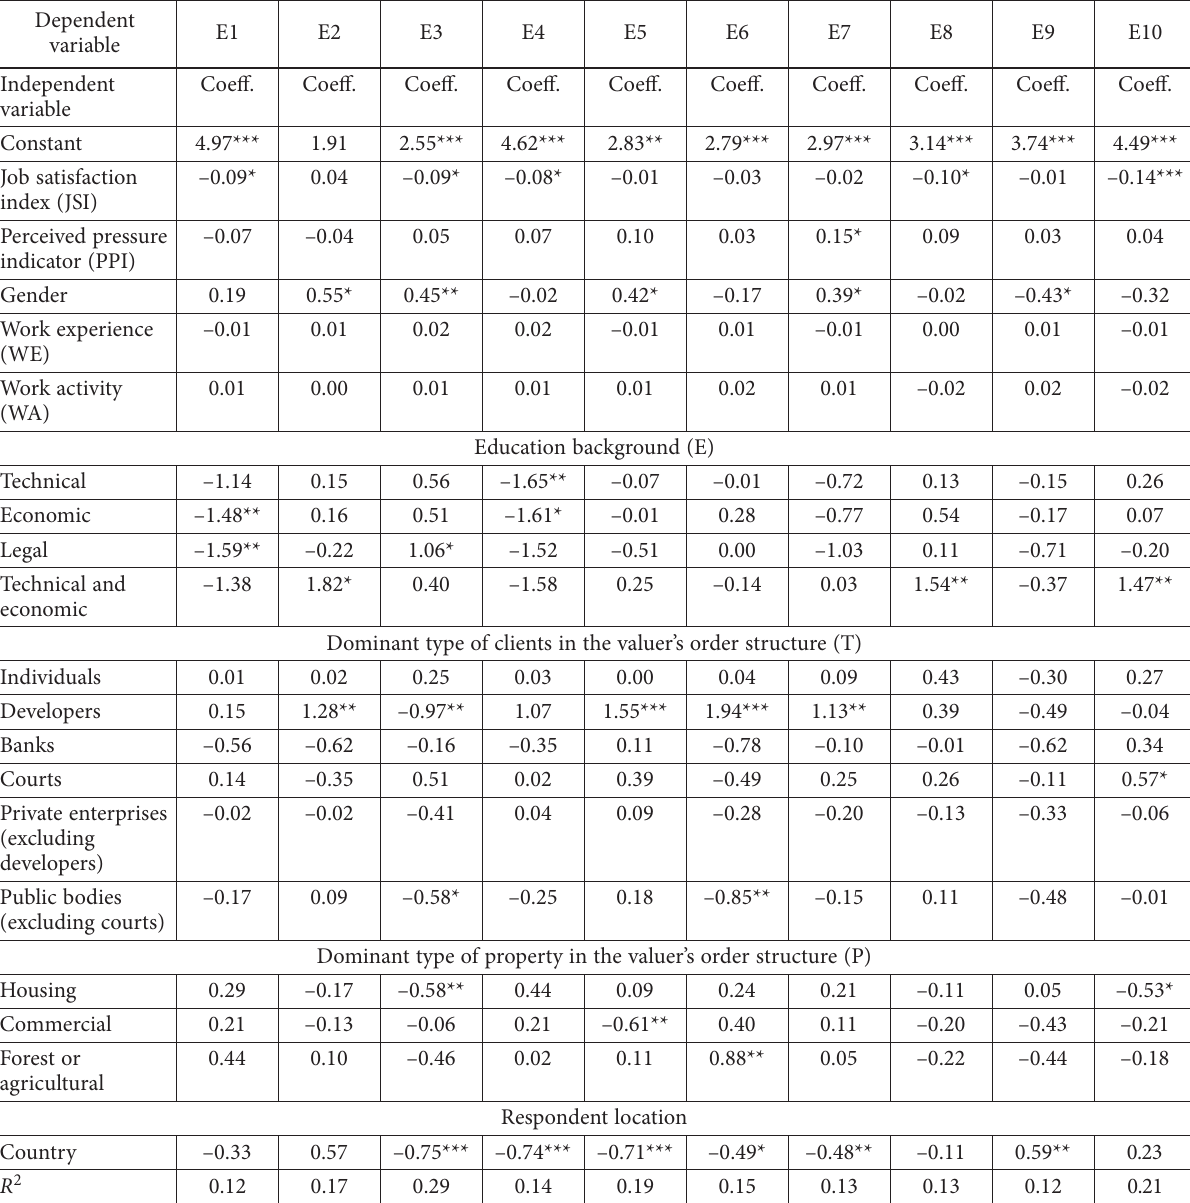
Table 4. Models estimates (OLS) for each ethical dimension